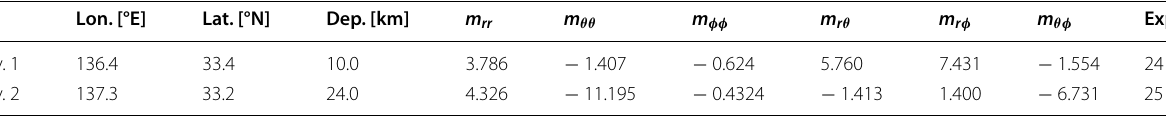
Table 2 Source parameters of Events 1 and